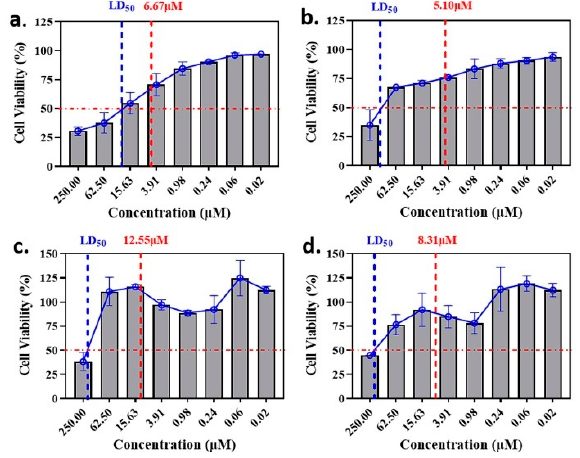
Figure 4. Comparison of LD 50 and IC 50 values of the candidate compounds. ( a – d ) indicate the comparison for compounds 17 , 47 , 62 and 147 .